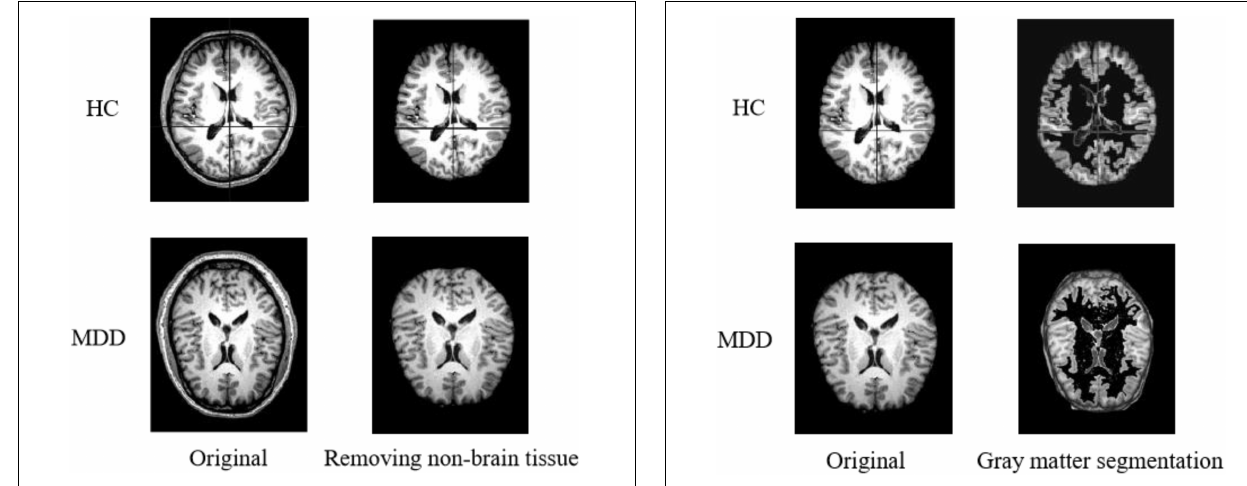
FIGURE 2 | Results of removing non-brain tissue. FIGURE 3 | Results of gray matter segmentation.